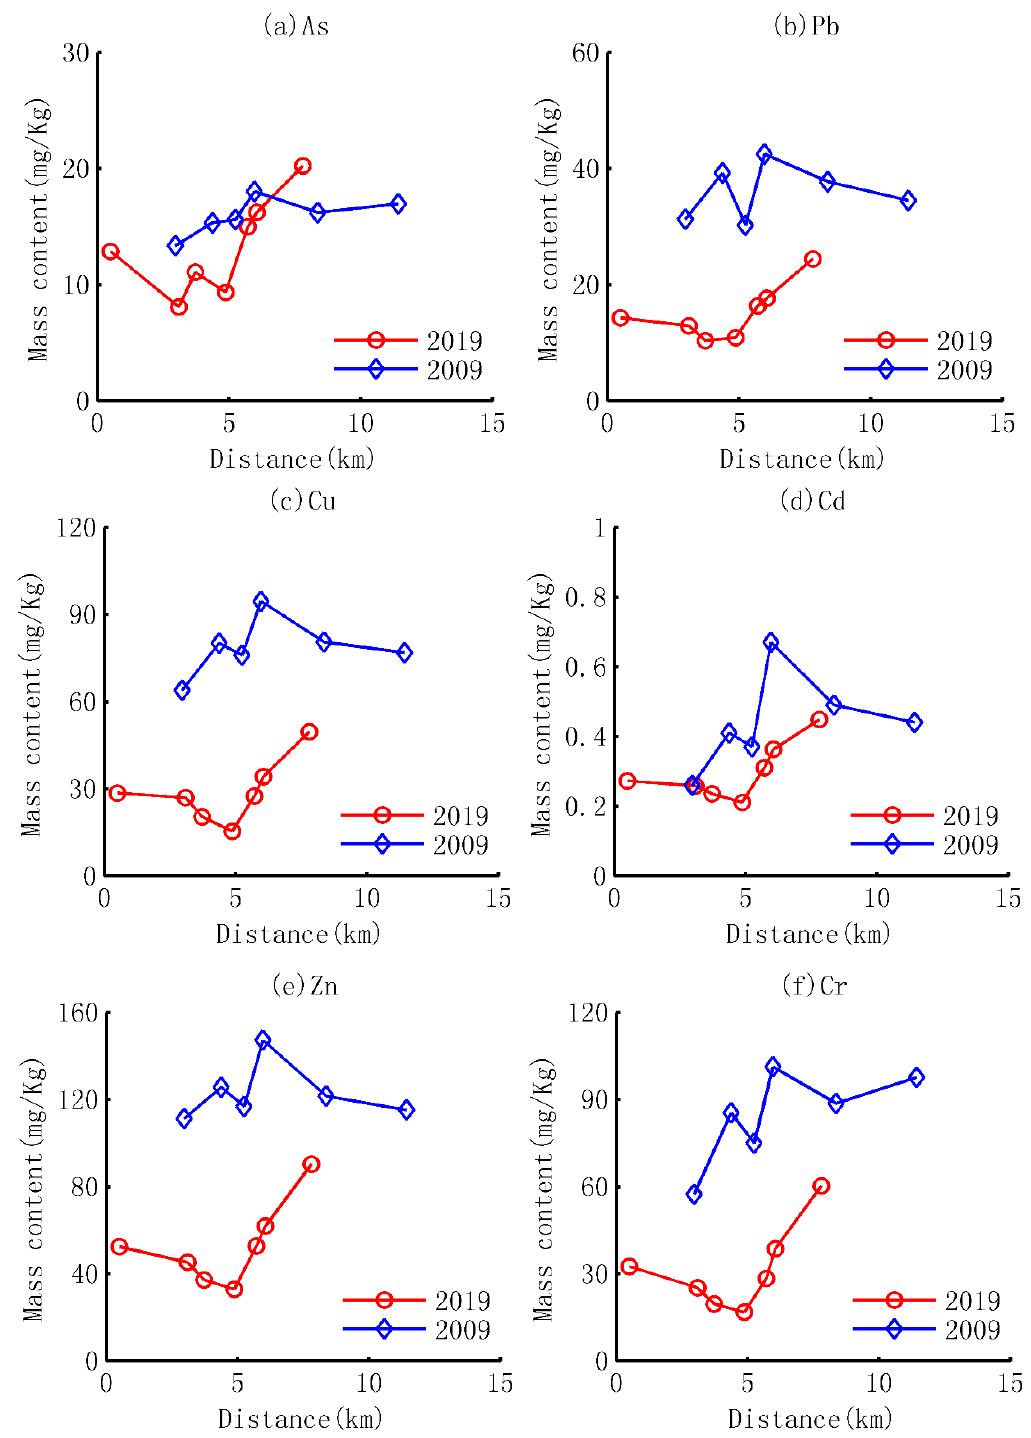
Figure 2. Comparisons on the average content of heavy metals between 2019 measured in this study and 2009 from literature [32] following the water flow direction; ( a ) As; ( b ) Pb; ( c ) Zn; ( d ) Cd; ( e ) Zn; ( f ) Cr.